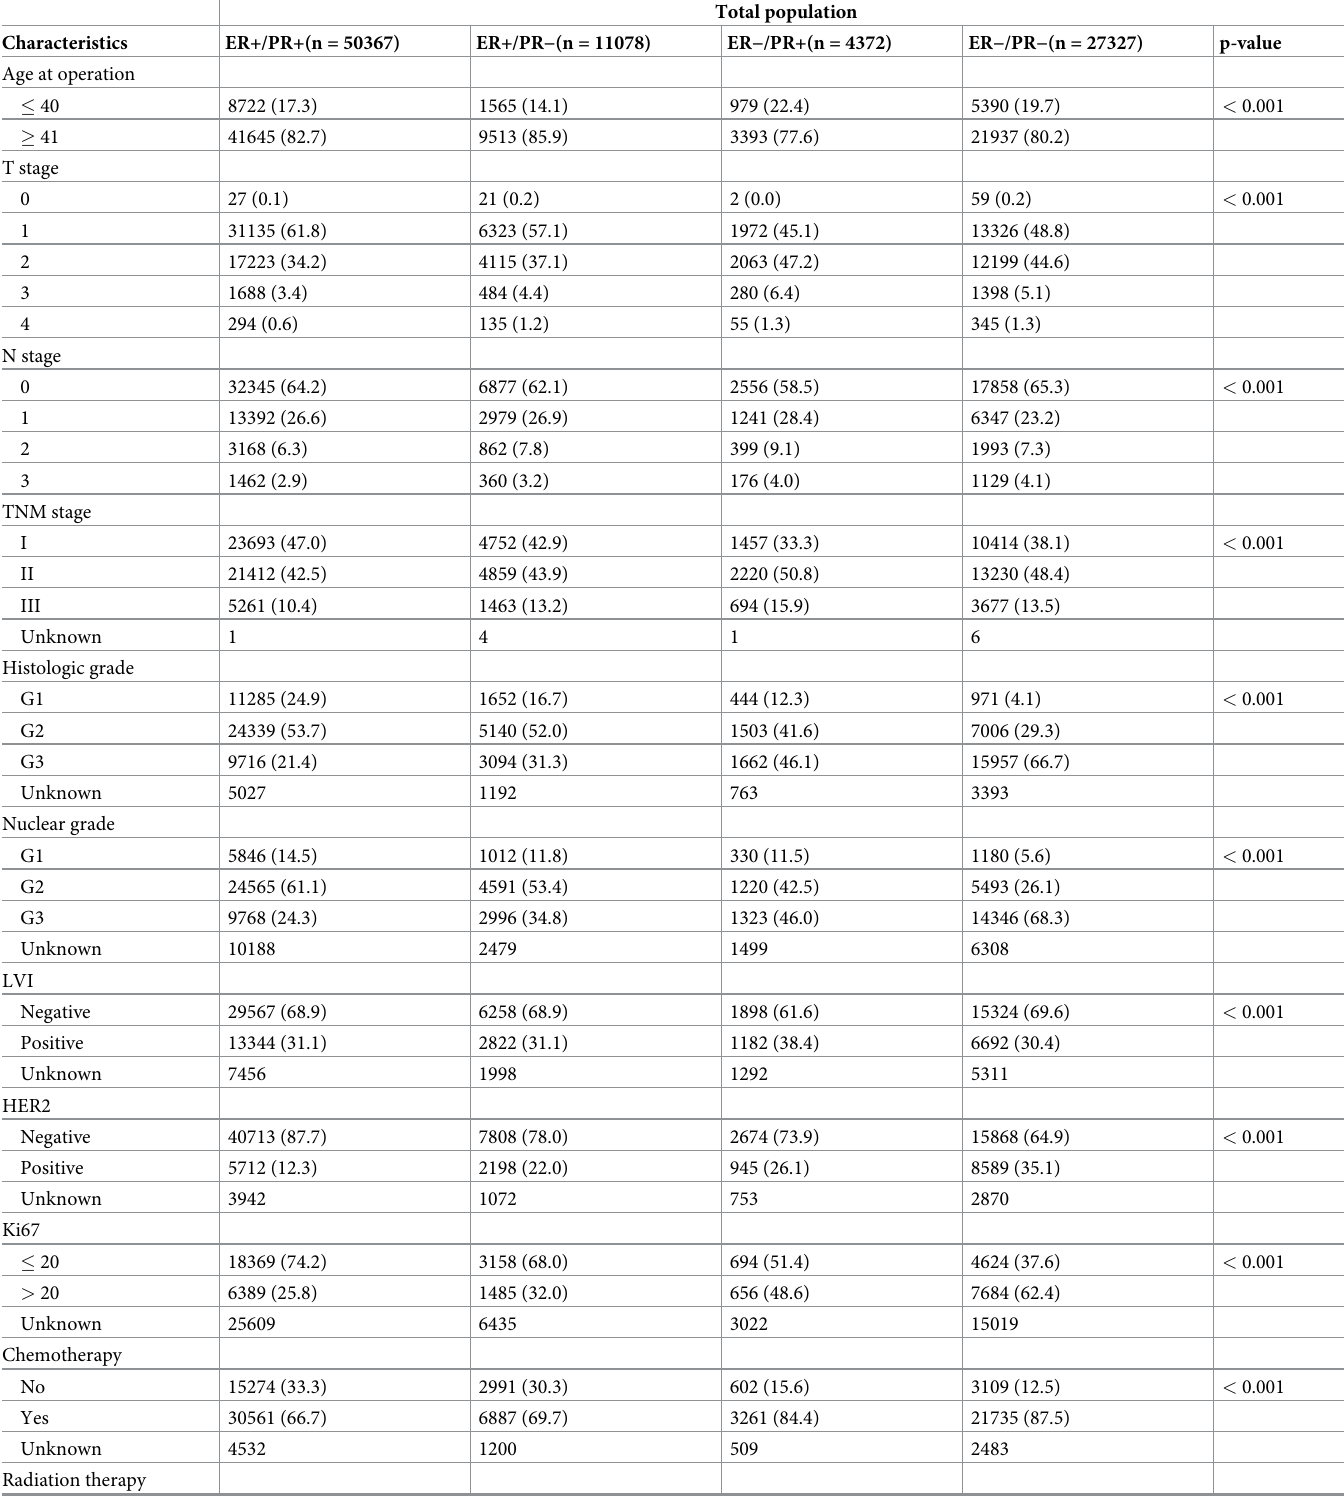
Table 2. Clinicopathological characteristics of hormonal expression subgroups in the total study population.